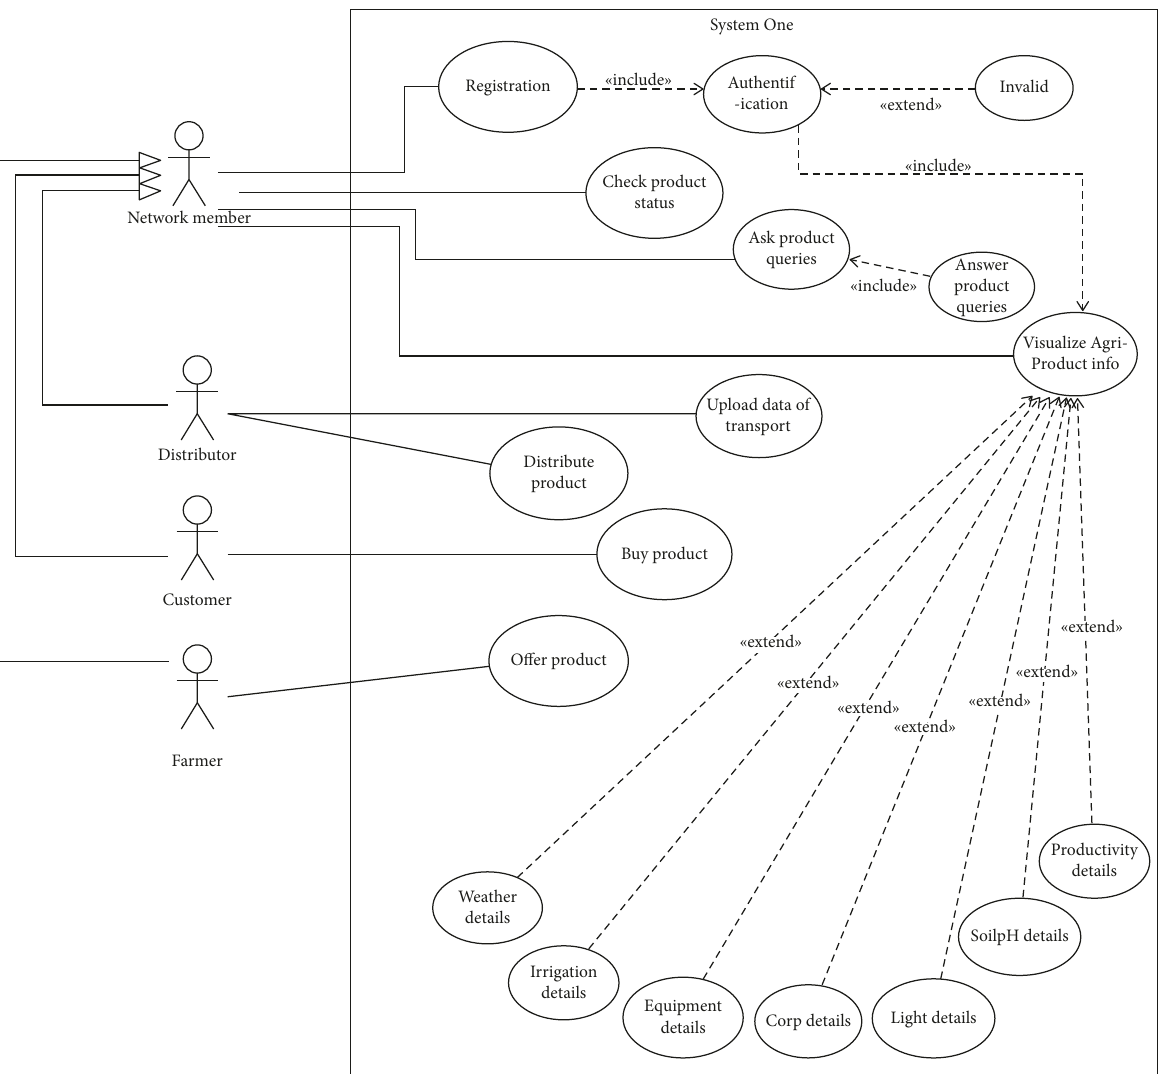
Figure 4: Use case diagram of the proposed